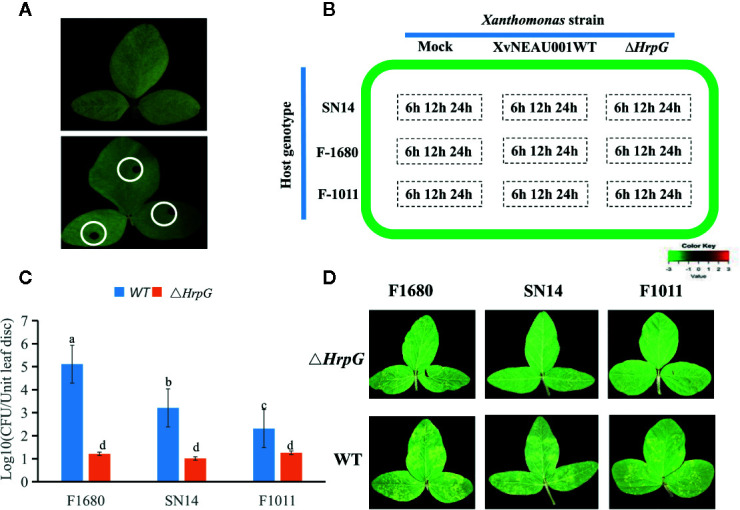
Phenotype analysis of F1011 and F1680. (A) phenotype of soybean first trifoliolate leaves after 4 days inoculated with Xanthomonas, bacteria number of leaf lesion (about 0.2 cm2) was counted on King’s medium B and used for phenotype evaluation. (B) RNA-seq treatment and sampling design. (C, D) Virulence analysis and phenotype of XvNEAU001WT and XvNEAU001ΔHrpG mutant on F1680, F1011 and their recurrent parent Suinong 14 (SN14). The bar and error bars is the mean and standard deviation. Bars with different letters are significantly different at p < 0.05 as analyzed by Duncan’s multiple comparison test. The days to measurement of the bacterial growth was four days after inoculation. Three trifoliate were used to calculate the number. The biological analysis on soybean germplasm was conducted for three times. ΔHrpG represents XvNEAU001ΔHrpG, WT represents XvNEAU001.